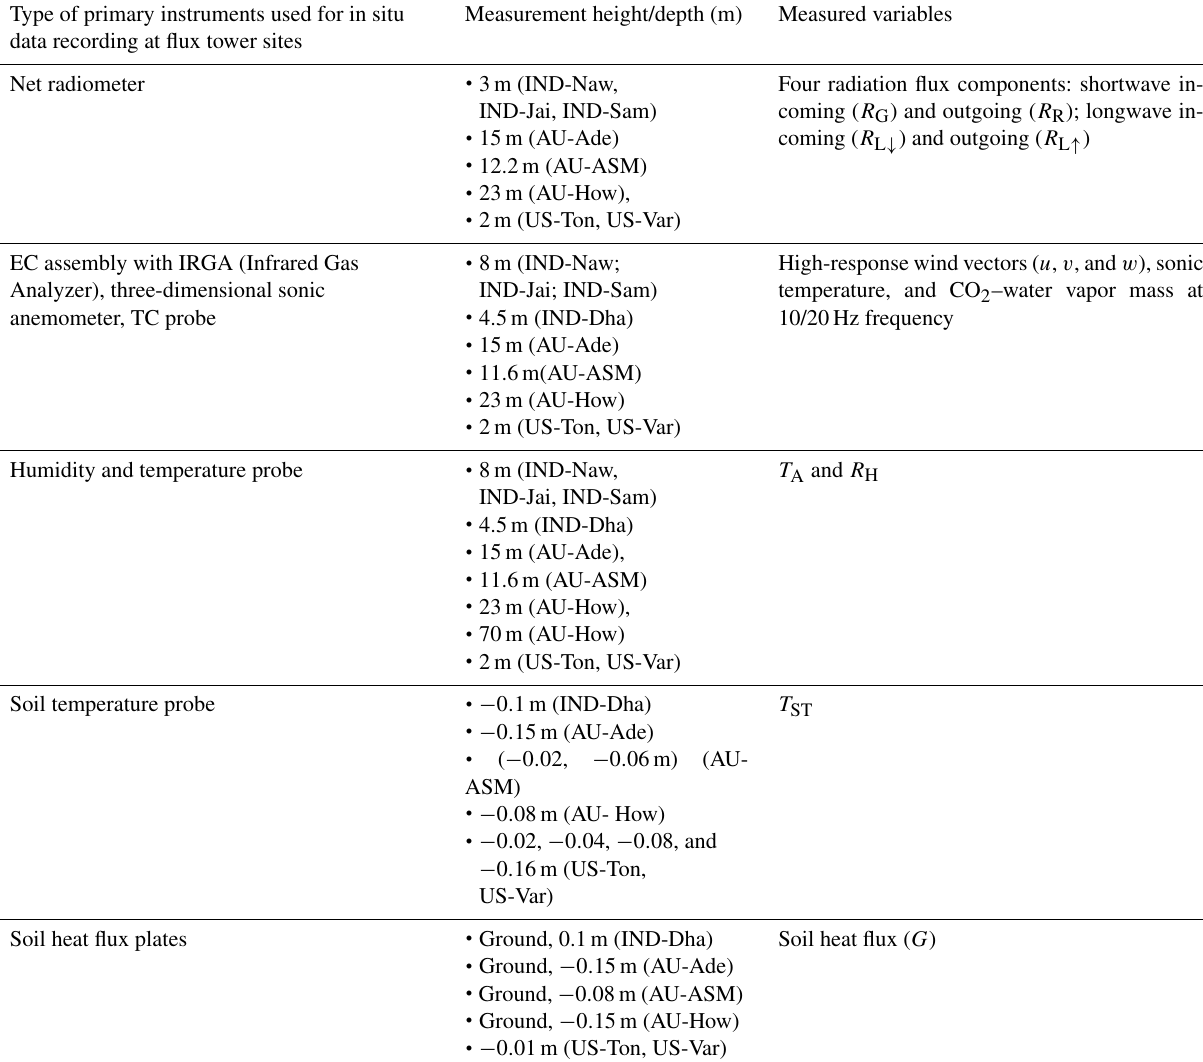
Table A2. Summary of instruments used, height or depth and period of measurements, and measured variables at nine EC flux tower sites. Type of primary instruments used for in